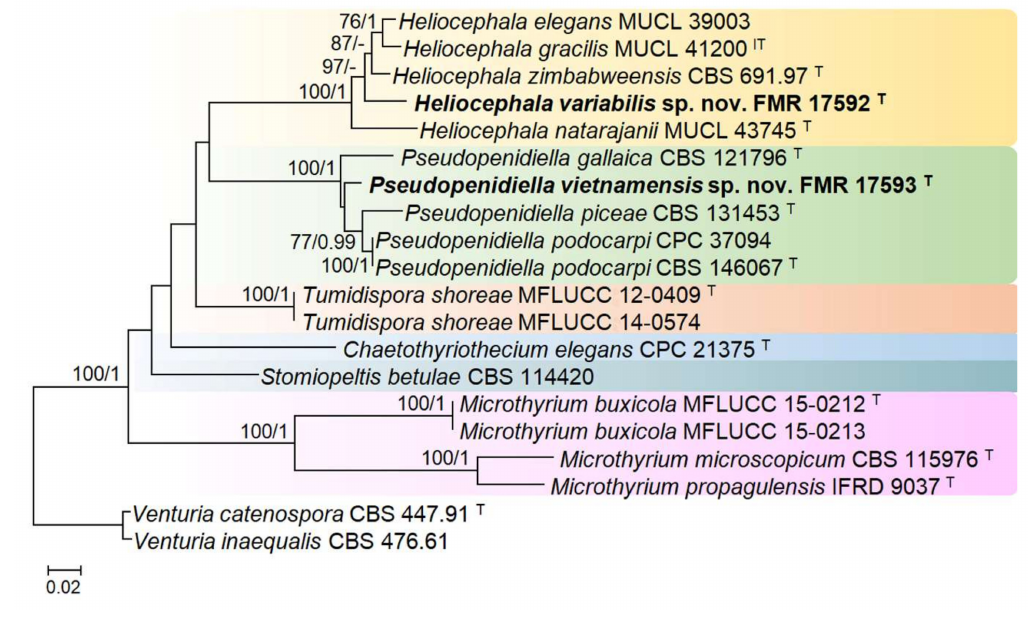
Figure 1. Maximum Likelihood (ML) tree constructed with the internal transcribed spacers (ITS) and large subunit (LSU) sequences of 18 strains representative of the family Microthyriaceae ( Microthyriales ). The phylogenetic tree was rooted with V. catenospora and V. inaequalis ( Venturiaceae , Venturiales ). Bootstrap support values for ML greater than 70% and Bayesian posterior probabilities greater than 0.95 are given near nodes. The names of the newly described species are in bold. Branch lengths are proportional to distance; T Ex-type strain; IT Ex-isotype